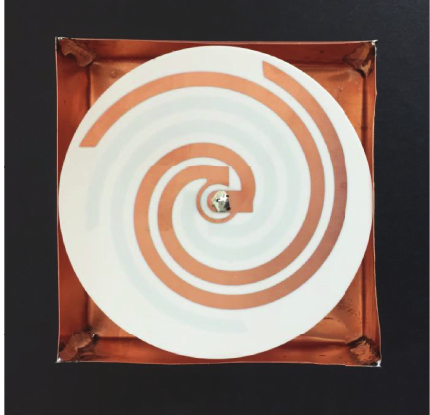
Figure 10: Top view of the fabricated dual-band GPS antenna.